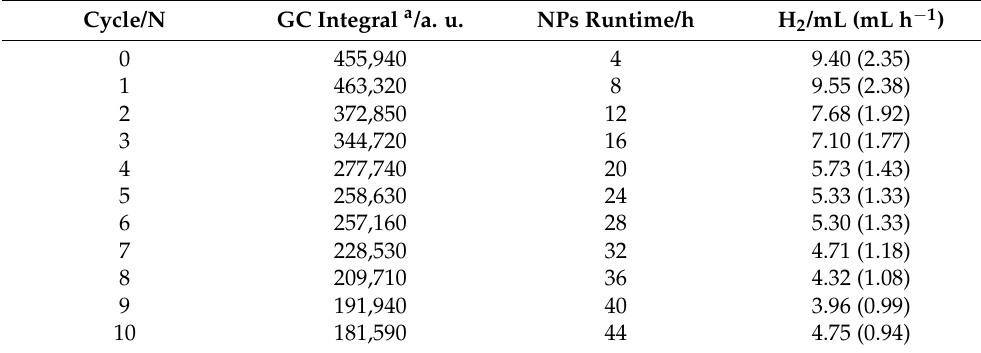
Table 6. Performed recycle dihydrogen generating experiments of two sample vials.